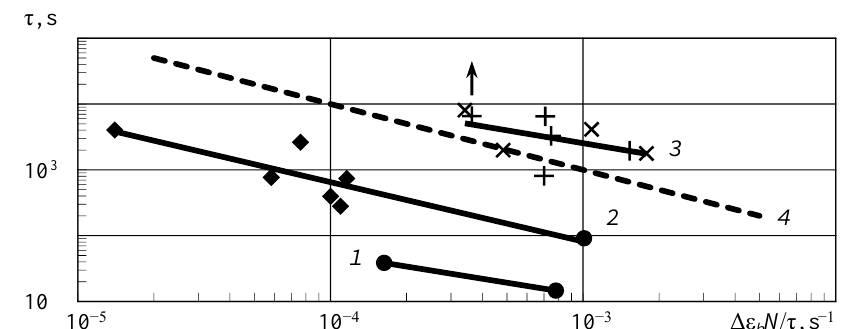
Fig. 3. Statistics of connection of inelasticity and longevity of specimens from carbon fiber reinforced plastic Torayca T700 with different reinforcement schemes : 1 , 2 – eight-layer unidirectional composite, 3 – the same composite with the addition of seven intermediate layers with perpendicular and diagonal stacking.